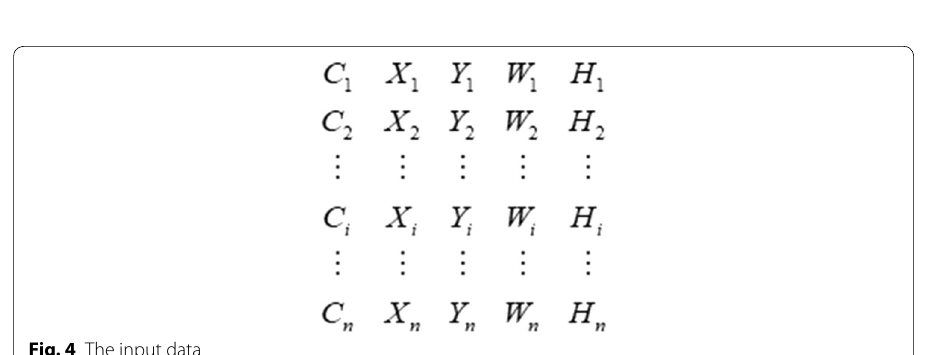
Fig. 4 The input